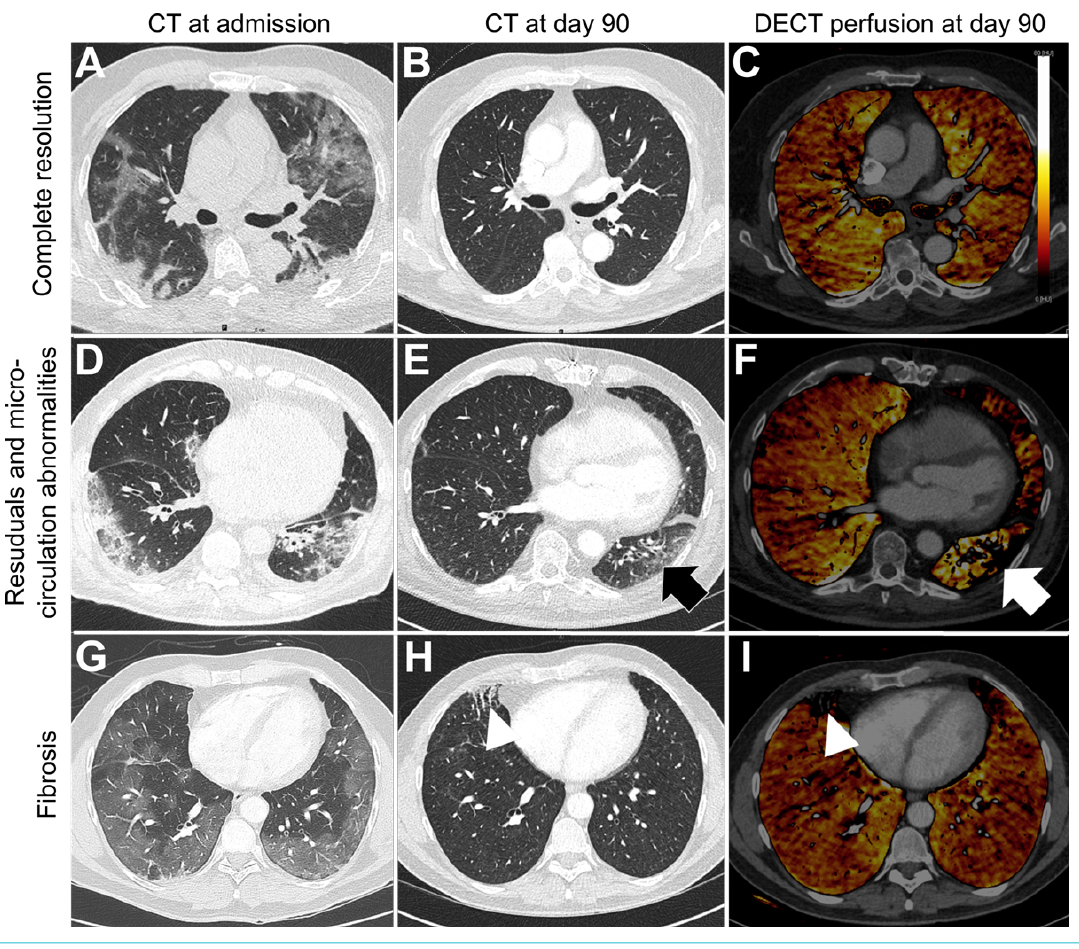
Figure 3: Evolution patterns of chest CT findings from admission to day 90.Axial CT images (A, B, D, E, G, H) and DECT overlay maps (C, F, I) presenting three evolution patterns of lung involvement from admission to day 90 observed in COVID-19 patients after treatment with tocilizumab.(A) Axial CT image is depicting a 62-old male patient with bilateral GGO and consolidations 3 days after onset of symptoms with complete resolution at day 90 (B) and no microcirculation abnormalities (C).(D) Axial CT image of a 78-old male patient 4 days after symptom onset showing bilateral GGO and reticulations (E) which seem to be associated with microcirculation abnormalities on DECT (F) at day 90. 49-old male patient receiving ECMO presenting profound bilateral mosaic pattern with GGO (G) 3 days after onset of symptoms showing focal fibrosis characterized by course reticulations and traction bronchiectasis (H) which correlates with focal perfusion defects on DECT (I) at day 90.GGO = ground glass opacity; DECT = dual energy computed tomography